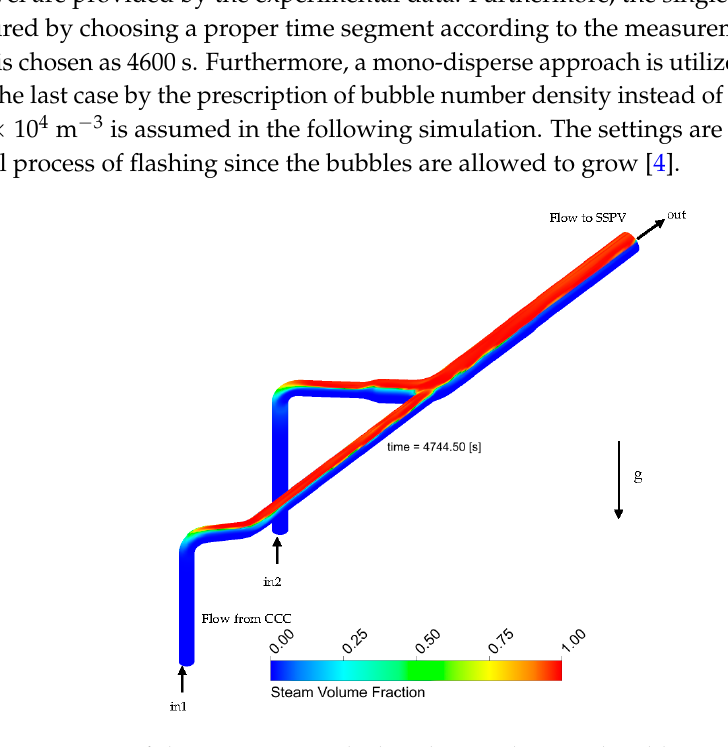
Figure 4. Segment of the riser pipe applied in the simulation colored by steam volume fraction at t = 4744.50 s. at t = 4744.50